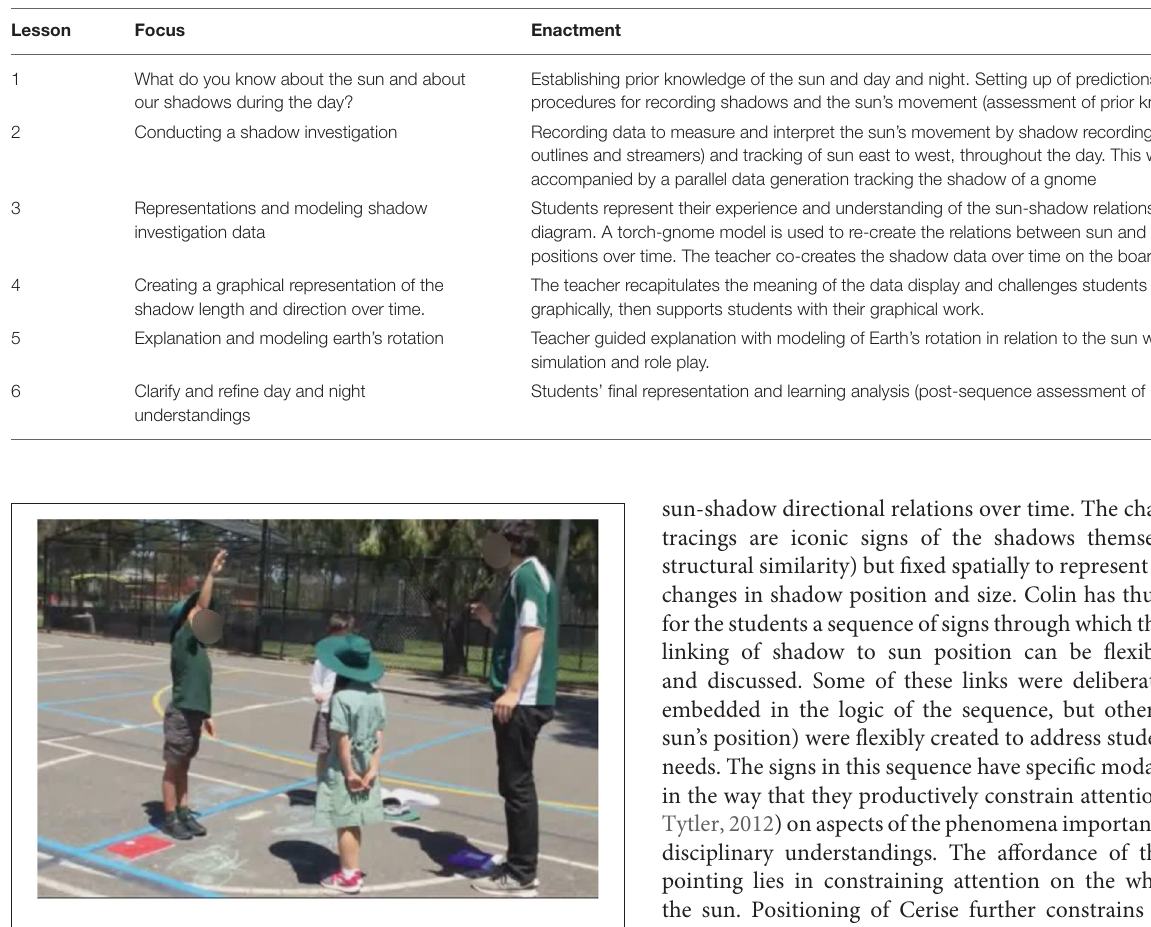
creating a sign representing the sun’s direction that could be directly linked to the shadow tracing at that point in